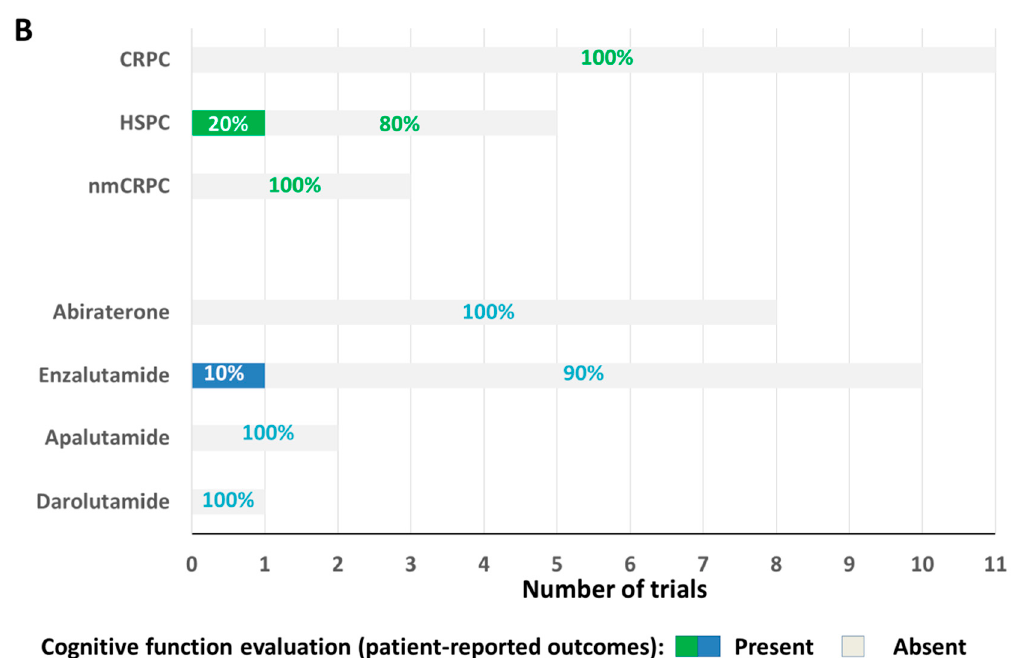
Figure 1. Availability of evaluation of cognitive function based on investigator assessment ( A ) and patient-reported outcomes ( B ) in the randomized trials (RCTs) of new-generation hormonal therapies.